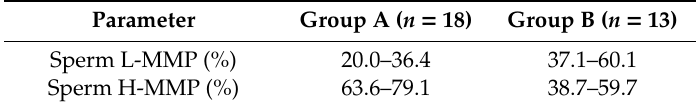
Table 2. Mitochondrial membrane potential (high, H-MMP, and low, L-MMP) (range) of the patients of groups A and B.